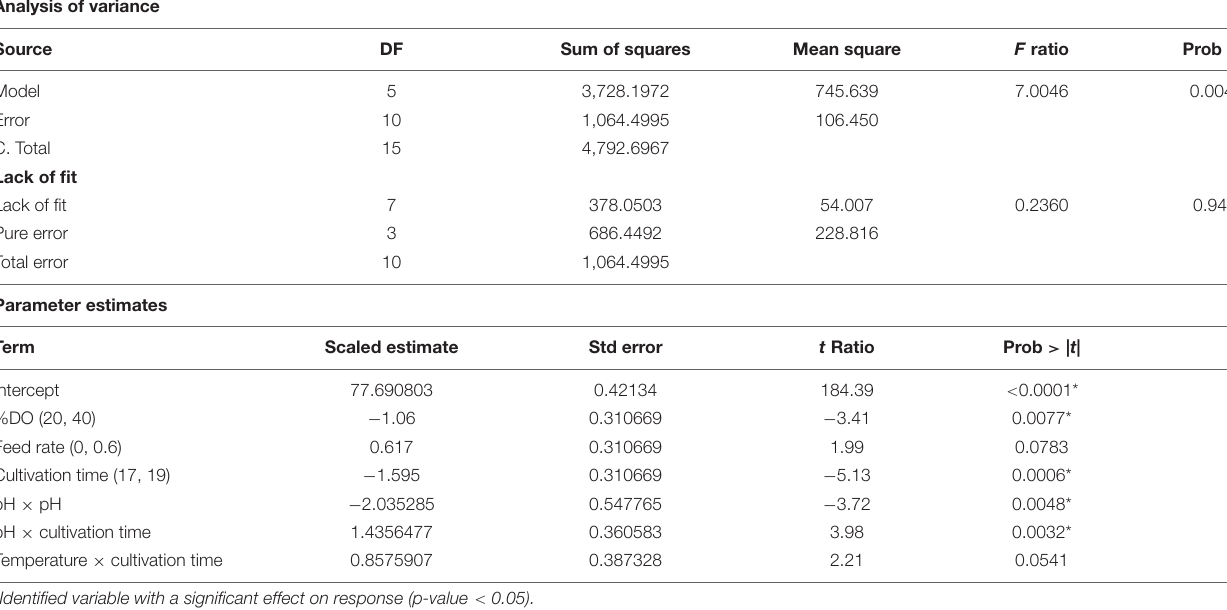
TABLE 3 | Regression analysis of predicted models for %SC.